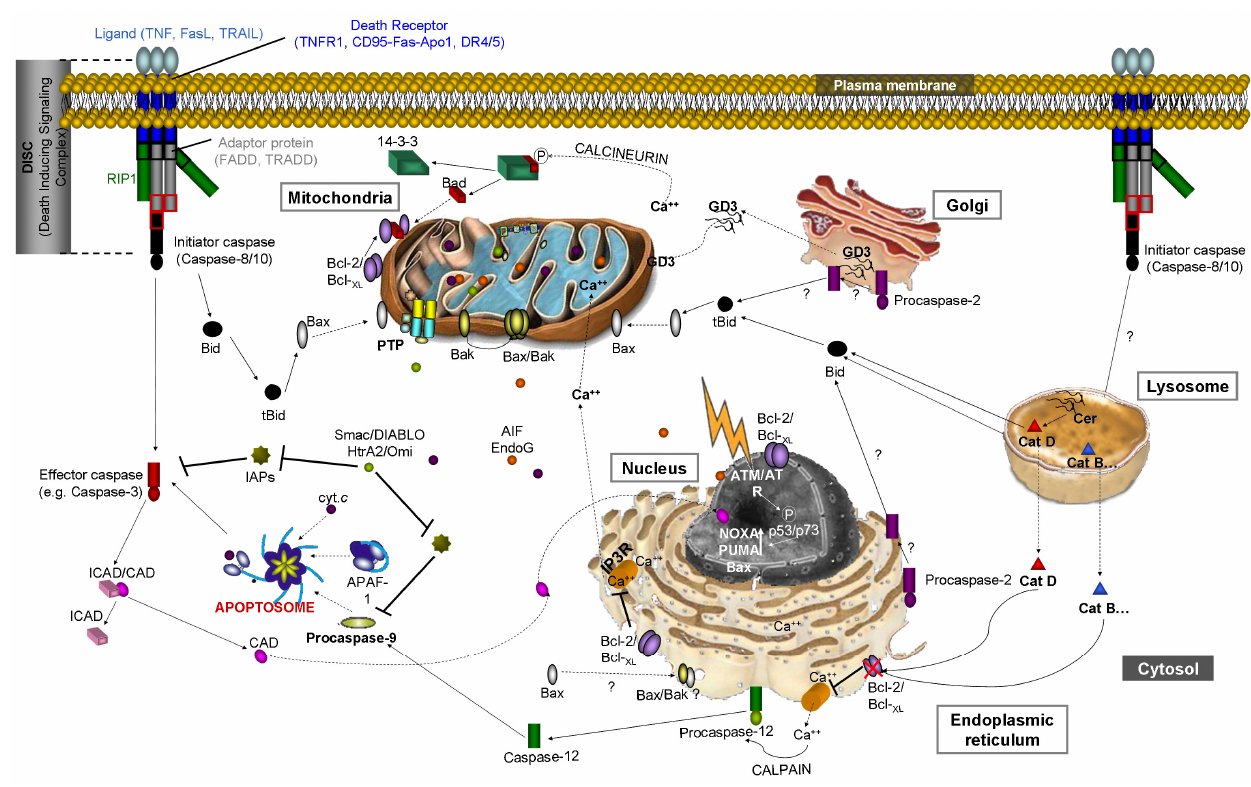
Figure 2. General view of the primary apoptotic pathways in the cell. Death receptor- dependent and –independent signaling pathways as well as signaling connections among different organelles are represented. Inhibitory effects are designed by while activation is designed by solid lined-arrows ( ). Dash lines (---) have been used to represent movement and interrogation marks (?) for proposed undetermined